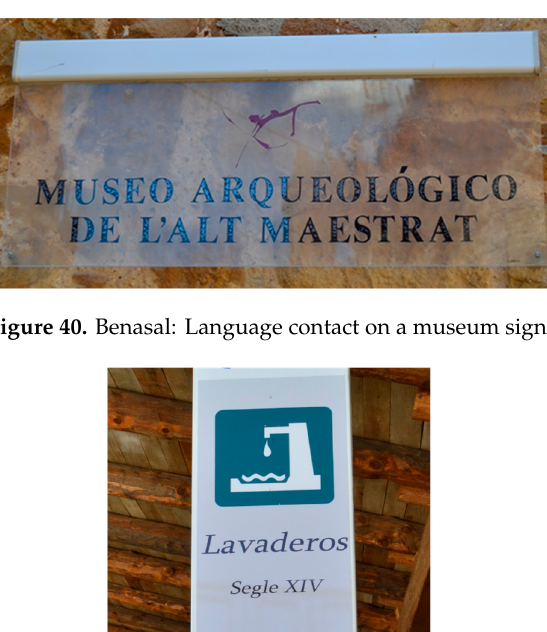
Figure 42. Almazora: Language contact on a driving school sign . The impact of bilingualism in the linguistic landscape can also be seen in Valencia. At a syntactic level, it can be seen how English rules are followed given that the Spanish adjective is placed before the noun (Figure 43). Figure 43. Valencia: Language contact on a food shop sign .